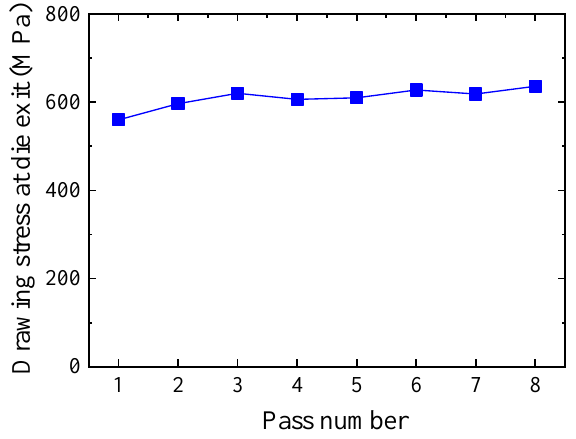
Figure 10. Drawing stress at the die exit.